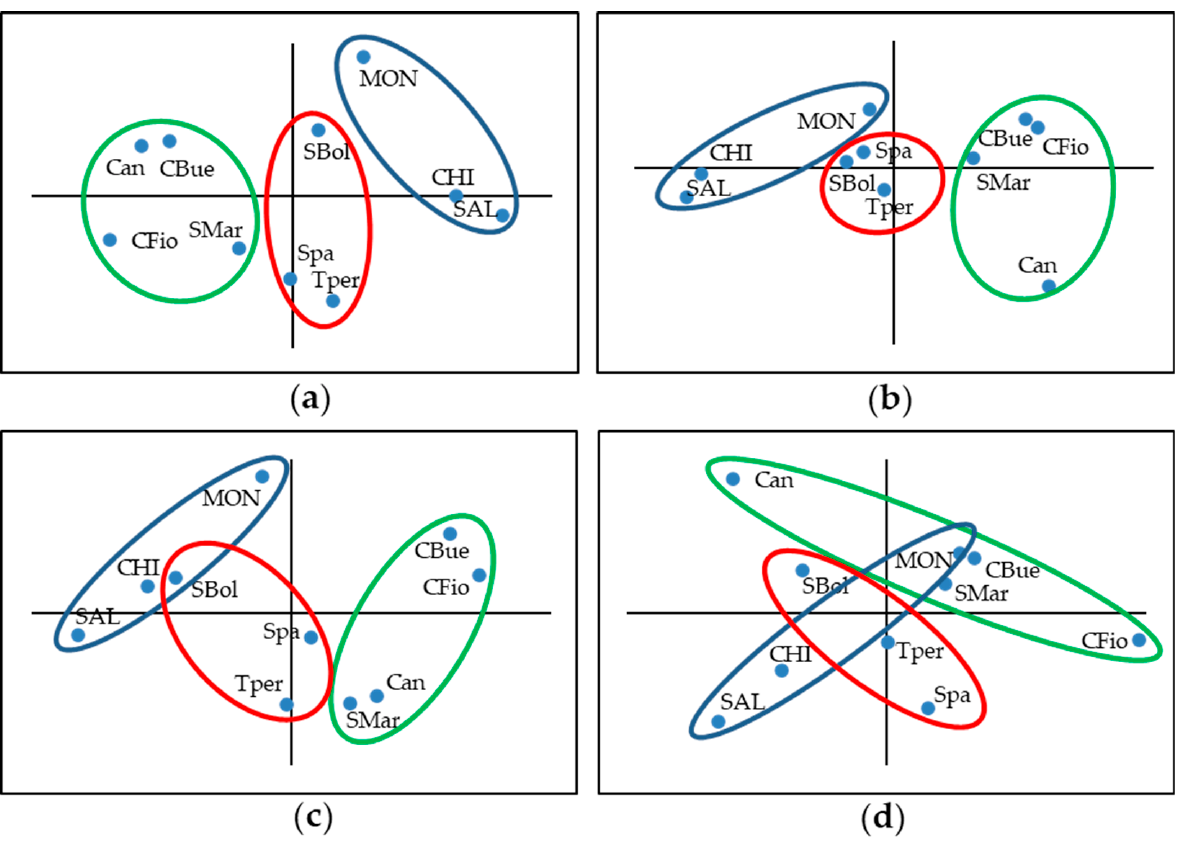
Figure 4. PC1 × PC2 plots of the ten studied varieties after principal component analysis of plant height, stigma position, pollen viability, number of flowers per inflorescence, and fruit set according to the cultivation under ( a ) control and ( b ) heat conditions in 2007 and under ( c ) control and ( d ) heat conditions in 2019. Variety names are abbreviated as follows: Chico III, CHI; Monalbo, MON; Saladette, SAL; Canestrino di Pisa, Can; Costoluto fiorentino, CFio; Cuor di bue, CBue; San Marzano, SMar; Scatolone di Bolsena, SBol; Spagnoletta, Spa; Tondo Perugia, Tper. Multivariate analysis on 2019 data explained 76% and 63% of the variability with the first two PCs under control and heat conditions, respectively. In this case, PC1 was positively loaded by PH and SP under both conditions (Table S3). In the control field, FSET also had an important negative loading on PC1. Main loadings for PC2 were PV (positive) in the control and FSET (negative) in the heat field. PC1 loadings made the topography of accessions under control conditions mirror the one observed in 2007;